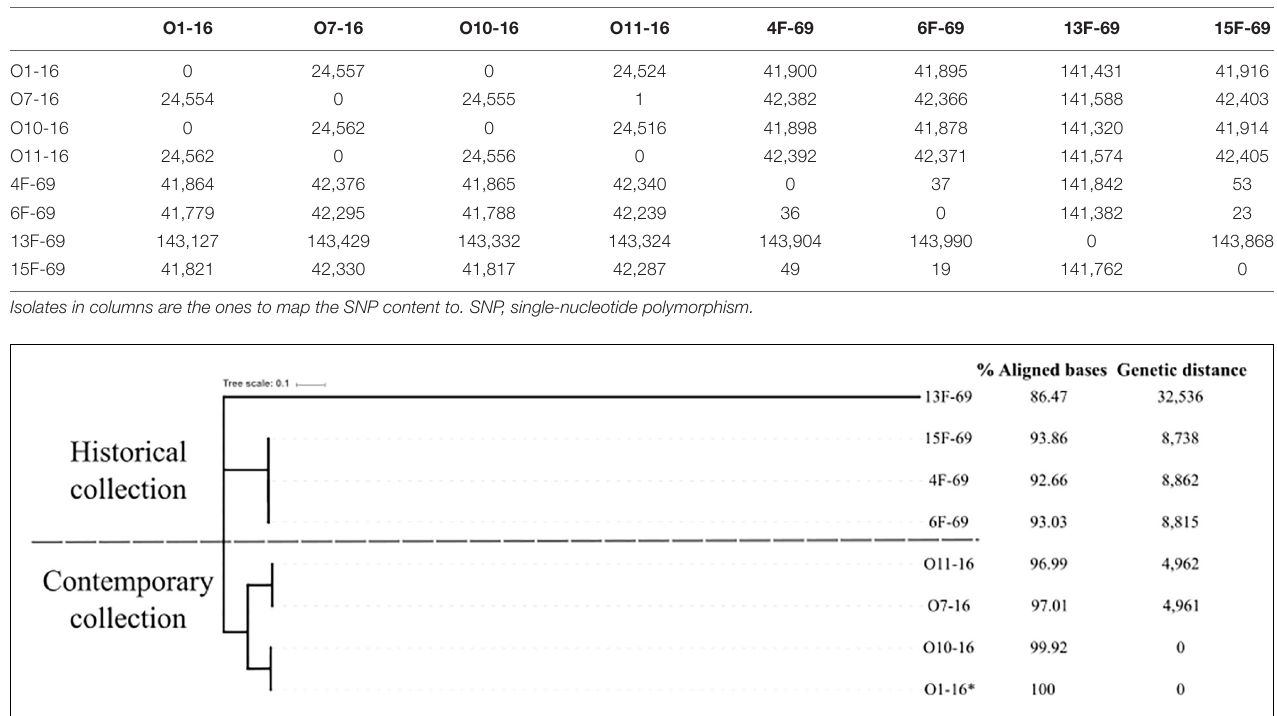
TABLE 6 | SNP matrix including all SNPs present between pairs of isolates.